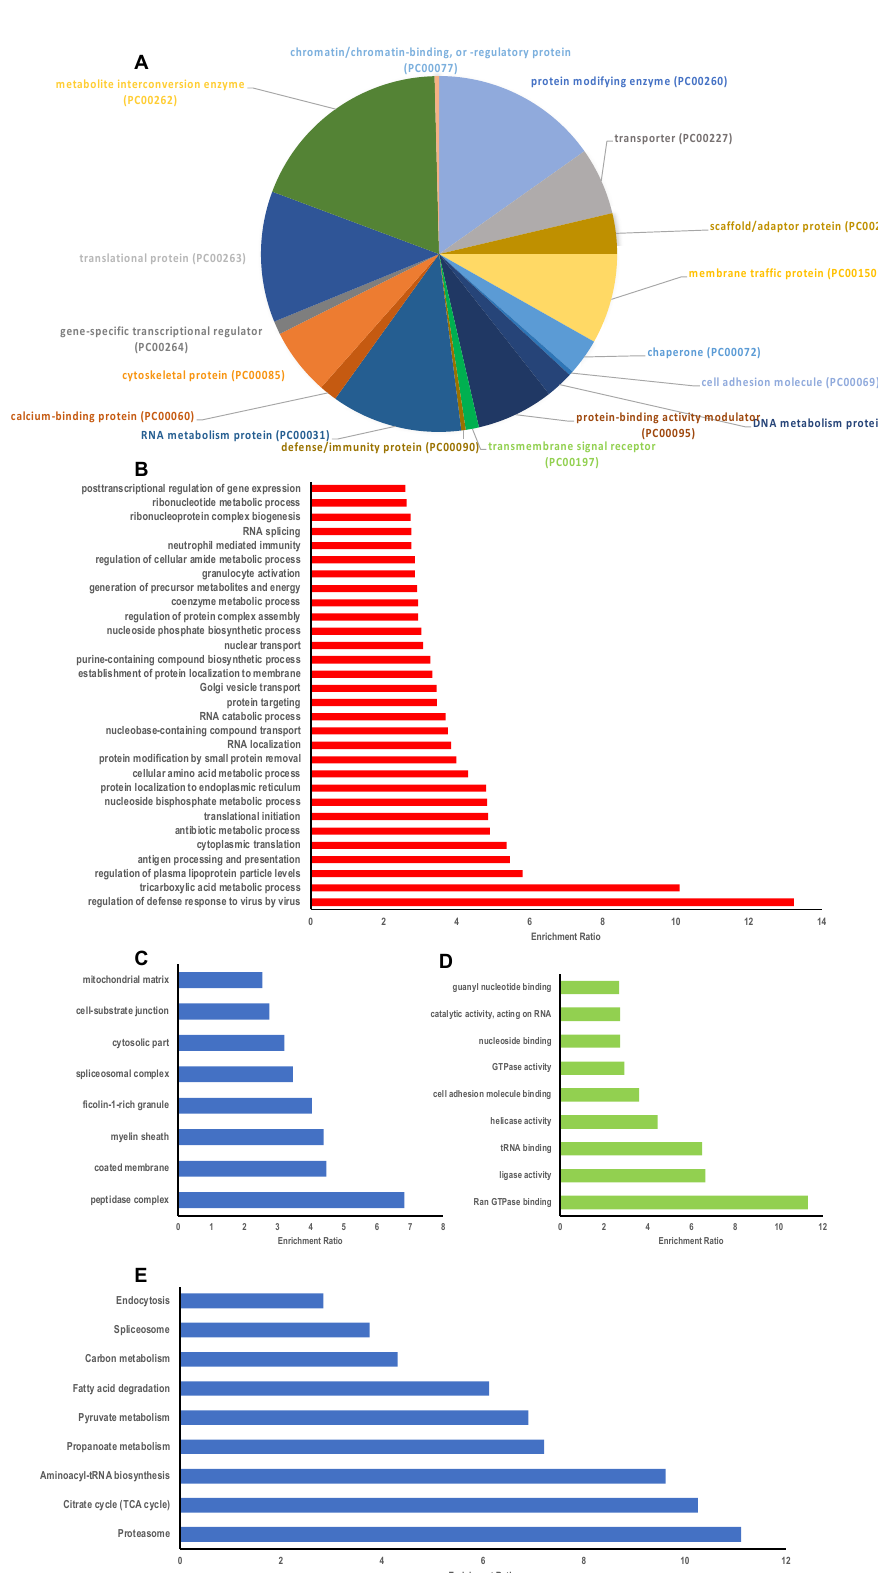
Figure 6. Bioinformatic characterization of EA.hy926 proteins modified by 2-ClHDyA. ( A ) Dis- tribution of 2-ClHDyA-modified proteins by protein class analyzed using Panther; ( B – E ) Over repre- sentation analysis using the Web-based Gene Set Analysis Toolkit (WebGestalt). Enriched categories in Gene ontology (GO) Biological function ( B ); Cellular component ( C ); Molecular function ( D ); and KEGG Pathway using Bonferroni p < 0.05 for computing FDR ( p < 0.05) ( E ).